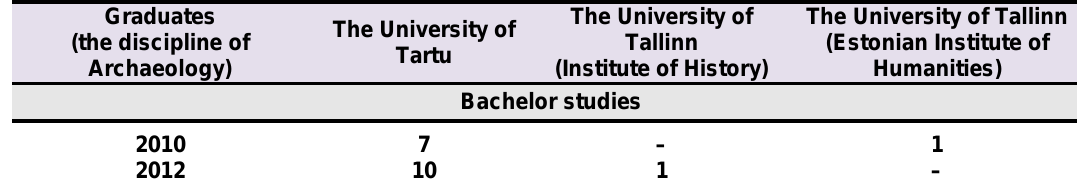
Table 9 - The graduates of Bachelor studies in 2010 and 2012